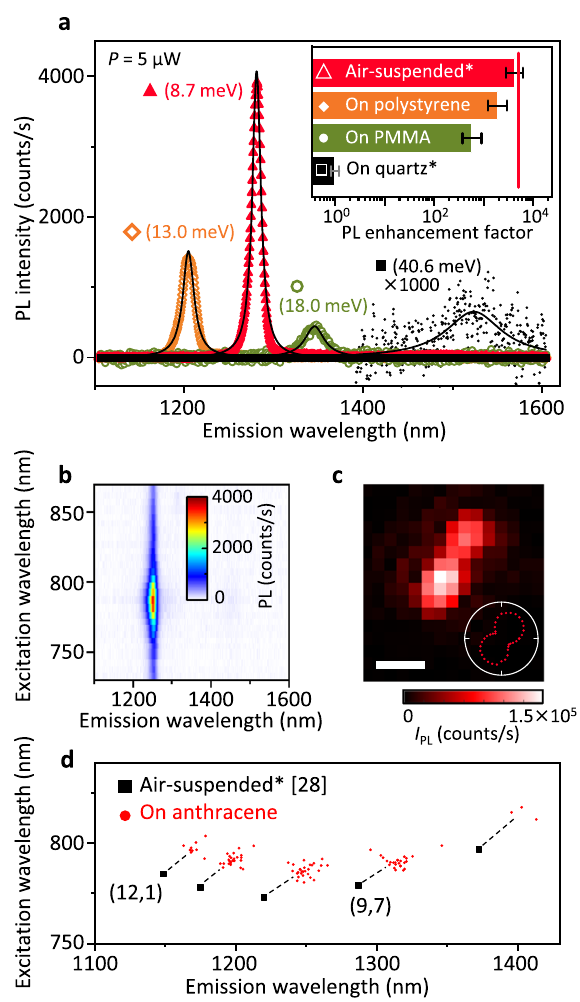
Fig. 3 PL properties of CNTs on various surfaces. a Typical PL spectra with top ~0.1% of integrated PL intensity I PL for each sample at excitation power P = 5 μ W. Black solid lines are Lorentzian fi ts. Numbers in parentheses represent the full width at half maximum. Inset: PL enhancement factor in comparison with CNTs on quartz, at I PL with a relative frequency of 10 − 3 . Error bars are the I PL ranges that appear twice or half as frequently. Red vertical line represents the transferred air-suspended CNT in Fig. 2. The sample names with asterisks represent as-grown CNTs; otherwise, the CNTs are transferred via anthracene. b Typical PLE spectrum and c PL image at emission wavelength λ em of 1253 nm of a (10,5) CNT picked up on anthracene crystals. Inset: Polarization dependence of I PL . Scale bar is 1 μ m. d PLE peak positions of CNTs on anthracene (red dots), which are redshifted compared with as-grown suspended CNTs (black squares) 28 . P = 100 μ W is used in b – d